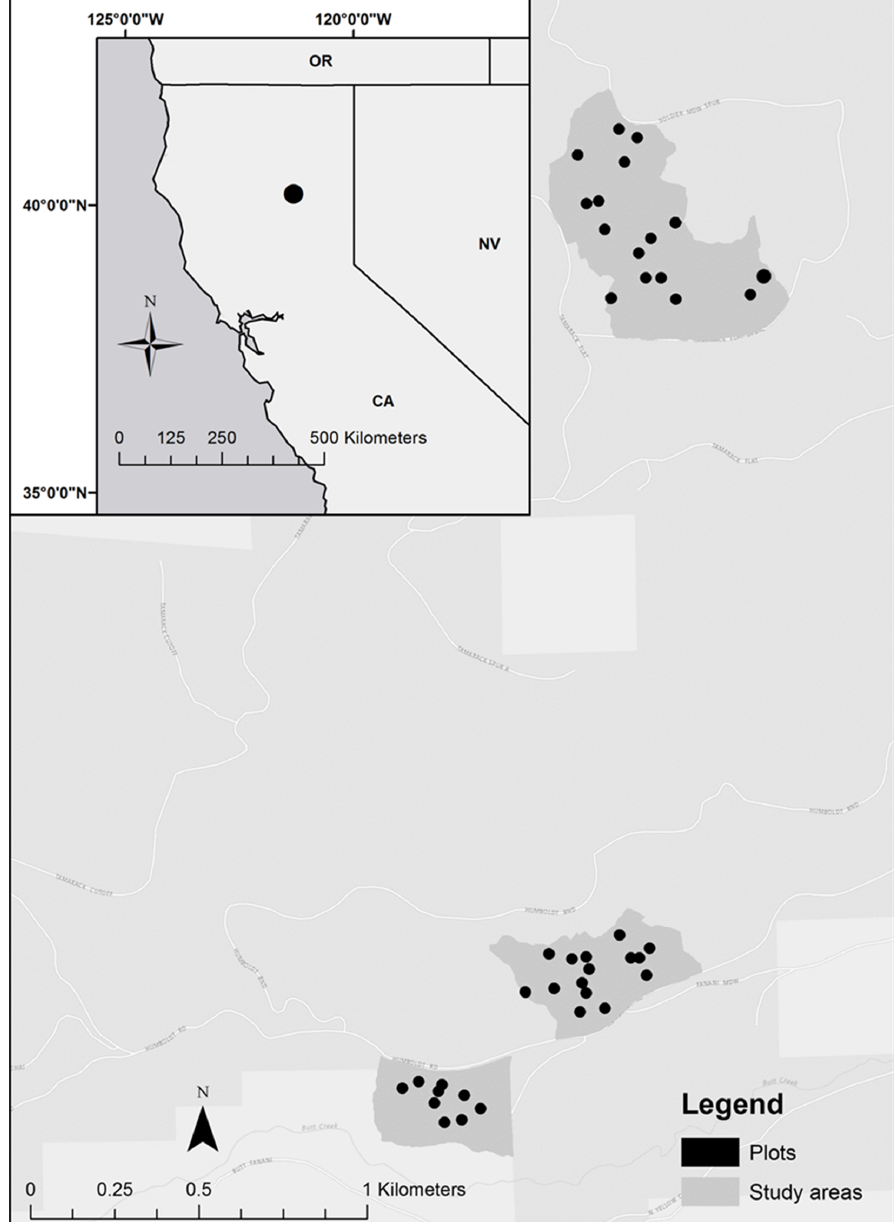
Figure 1. Map of study plots and forest structure at study areas in the southern portion of Lassen National Forest, northern California, southwest of Lake Almanor. Plots are indicated as black dots on the main map.